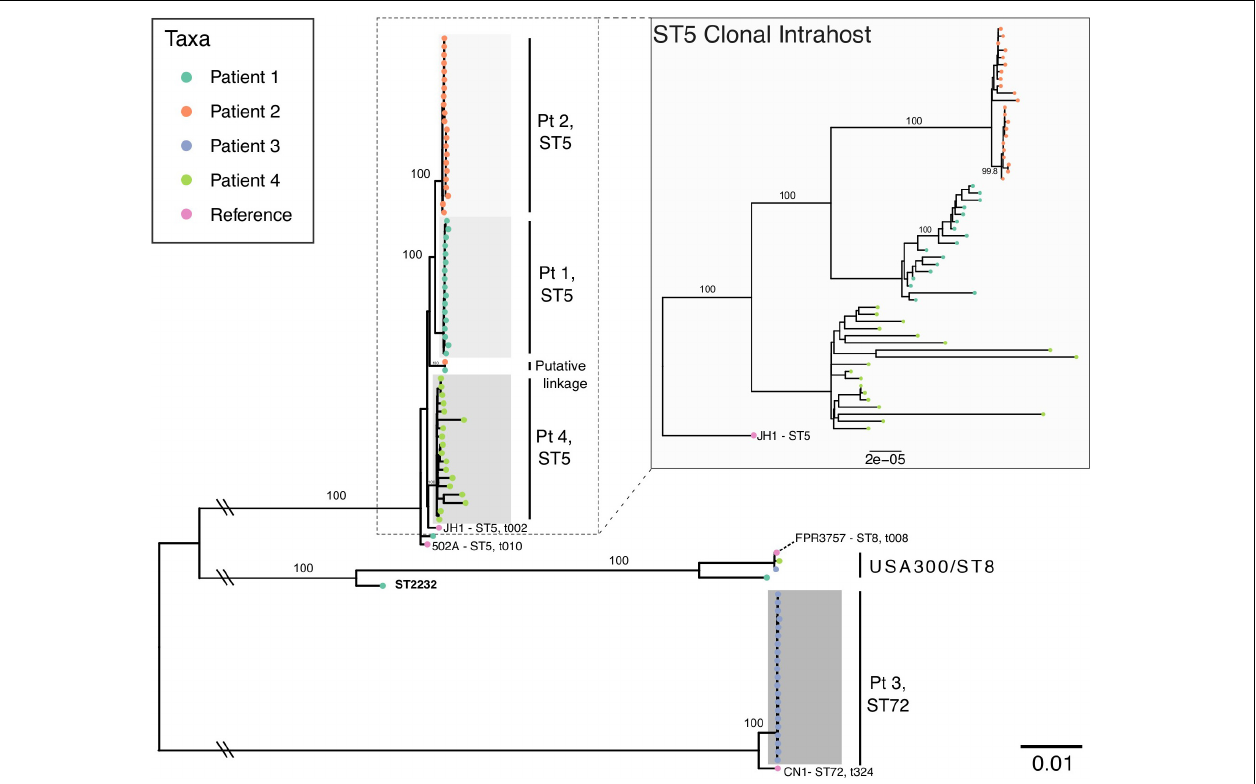
FIGURE 1 | Maximum likelihood phylogeny of all intrahost isolates from four patients with S. aureus reference genomes. The main phylogeny was inferred using RAxML on a core genome alignment of all intrahost isolates with four S. aureus reference genomes (JH1, 502A, FPR3757, and CN1), which are annotated with multilocus sequence type (ST) and spa type. Tip points are colored by patient and bootstrap values for major clades are annotated. Clades are shaded to identify clonal intrahost populations, which are labeled to the right. Double slashes indicate where the basal branches separating the ST5 and ST72 clades have been truncated. The inlayed phylogeny shows ST5 clonal intrahost isolates only and was inferred from a core gene alignment of 2,164 COGs (1,966,902 bp) rooted using the JH1 ST5 reference.